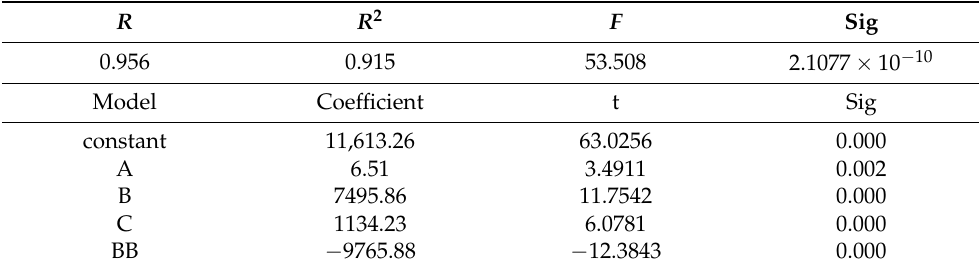
Table 6. Regression analysis results of current